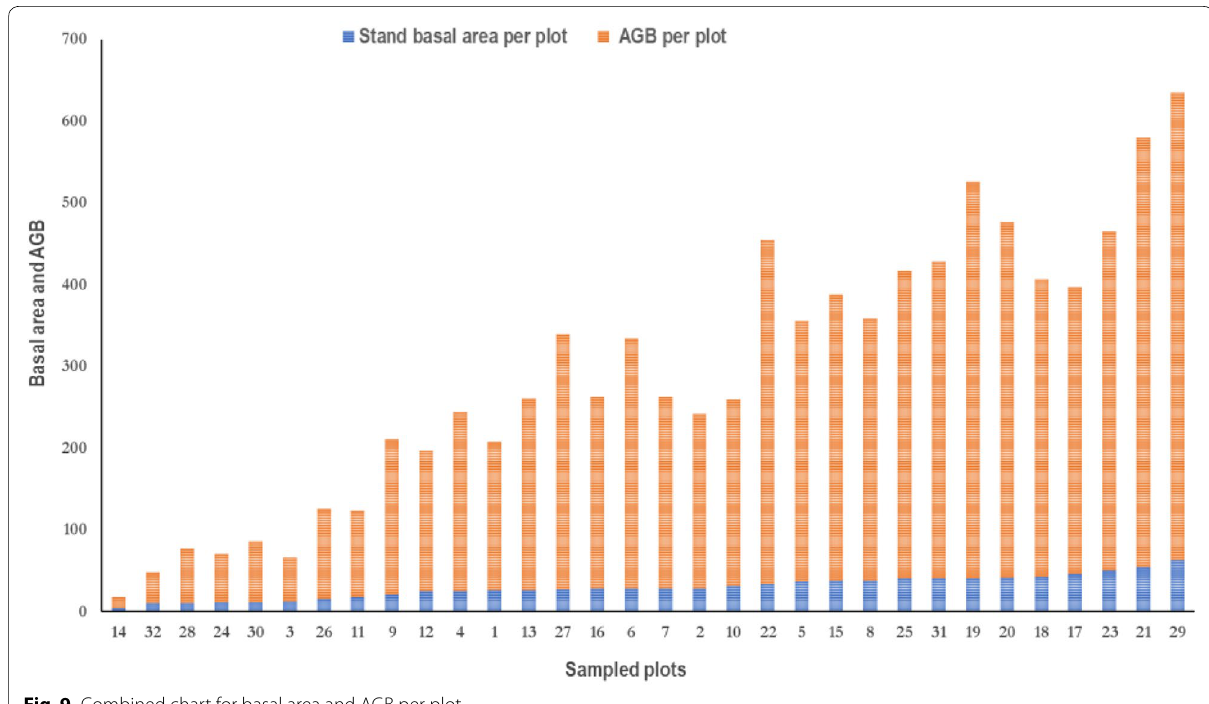
Fig. 9 Combined chart for basal area and AGB per